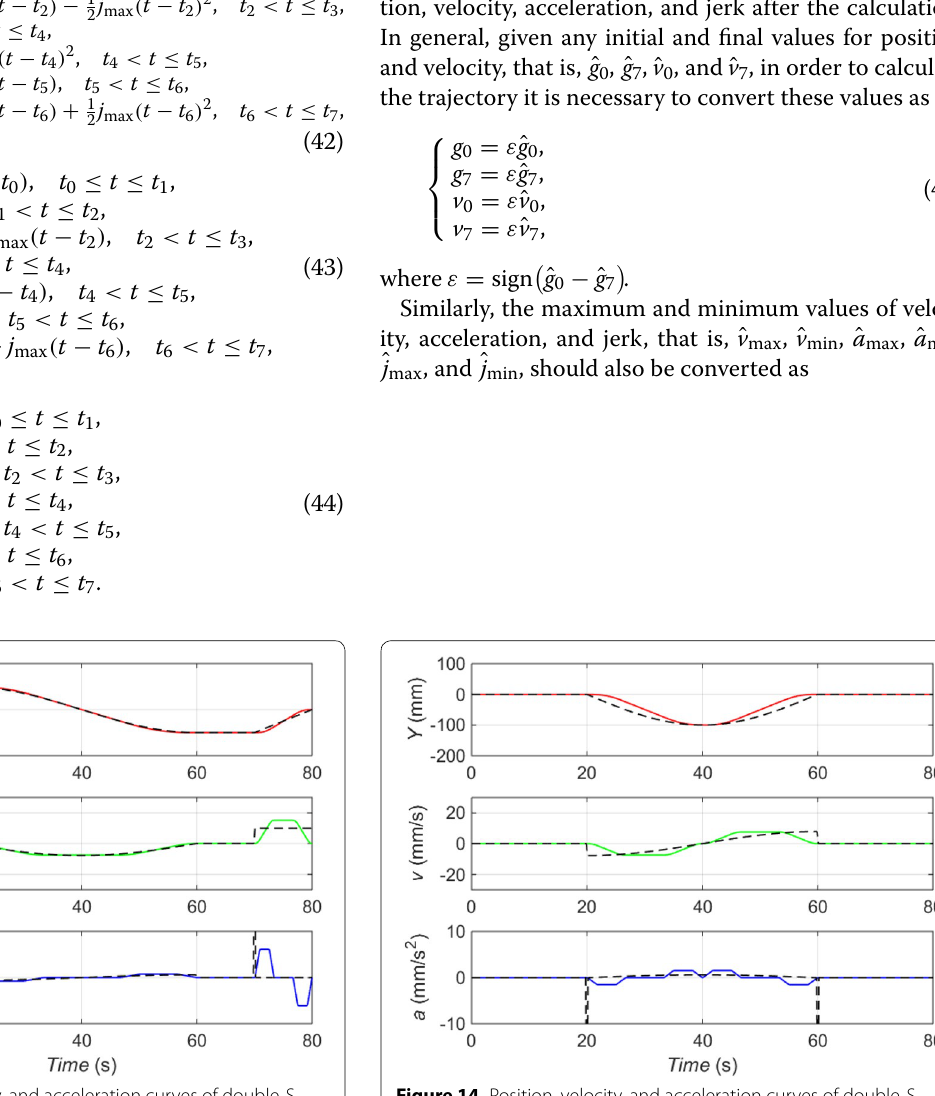
Figure 14 Position, velocity, and acceleration curves of double-S velocity curve planning in the Y